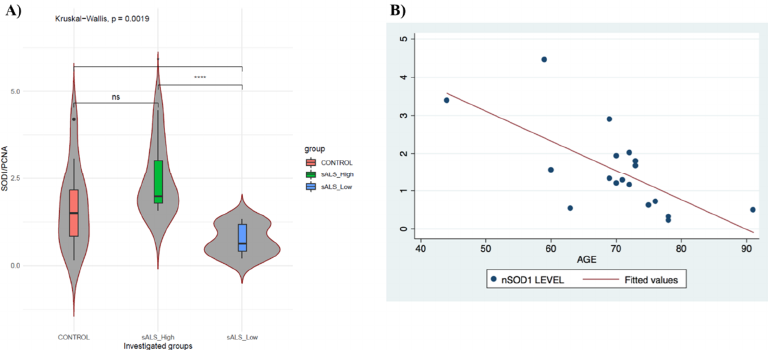
Figure 1. ( A ) PBMCs of sALS patients differ in nSOD1 distribution. Violin plots with boxplot showing distribution of SOD1 in control group ( n = 12; red), sALS patient group with “high” nSOD1 ( n = 8; green) and sALS patient group with “low” nSOD1 ( n = 10; blue). Data were analyzed by Kruskal–Wallis test. **** p < 0.005; ns = nonsignificant. Levels of nSOD1 correlate with patients’ age. ( B ) Scatter plot of age vs. nSOD1 levels in patients considered for this work; p -value = 0.0021; R 2 = 0.4456. nSOD1 amount is